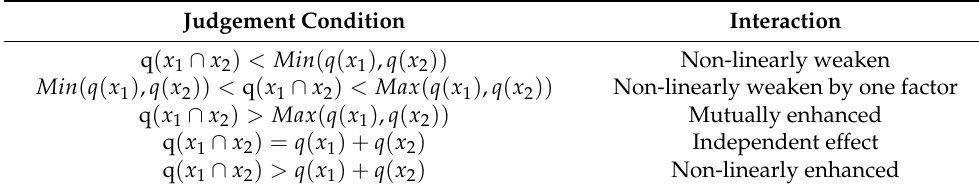
Table 2. Independent variable interaction